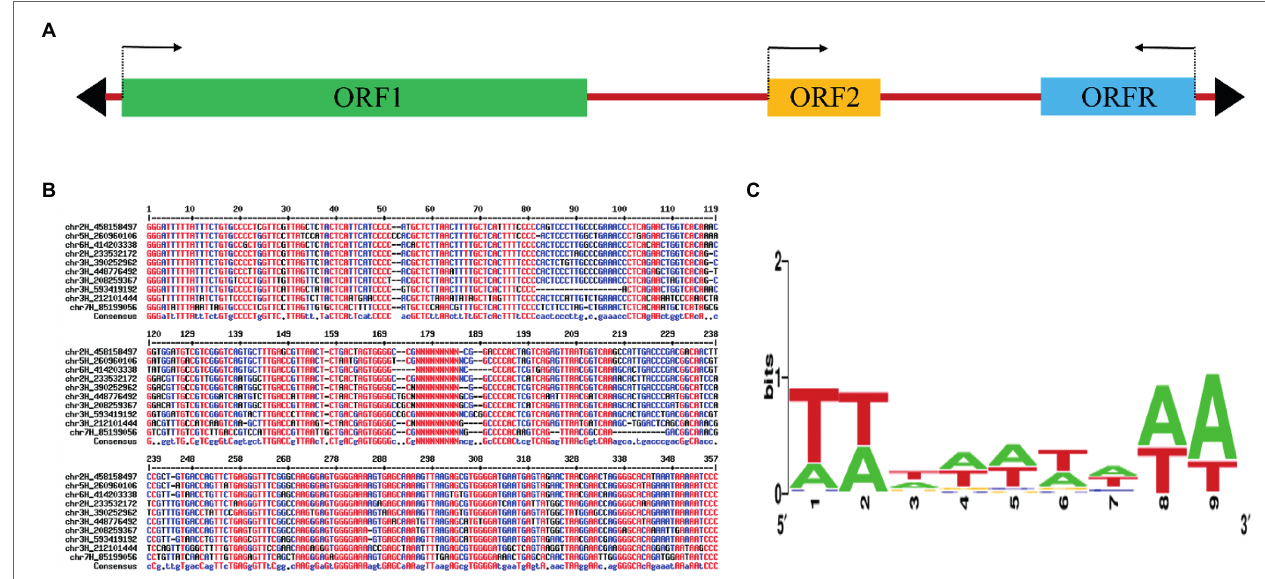
FIGURE 1 | A mutator transposon in barley. (A) The sequence structure of Hvu_Abermu . Colorful rectangles and black triangles represent the open reading frames (ORFs) and terminal inverted repeats (TIRs) of the transposon and the arrows indicate the transcription orientations. (B) Sequence alignment of 5 ′ and 3 ′ TIRs of 10 Hvu_Abermu transposons. The internal regions of transposons are indicated by 20 Ns. (C) WebLogo of 9-bp TSDs of 267 Hvu_Abermu elements in